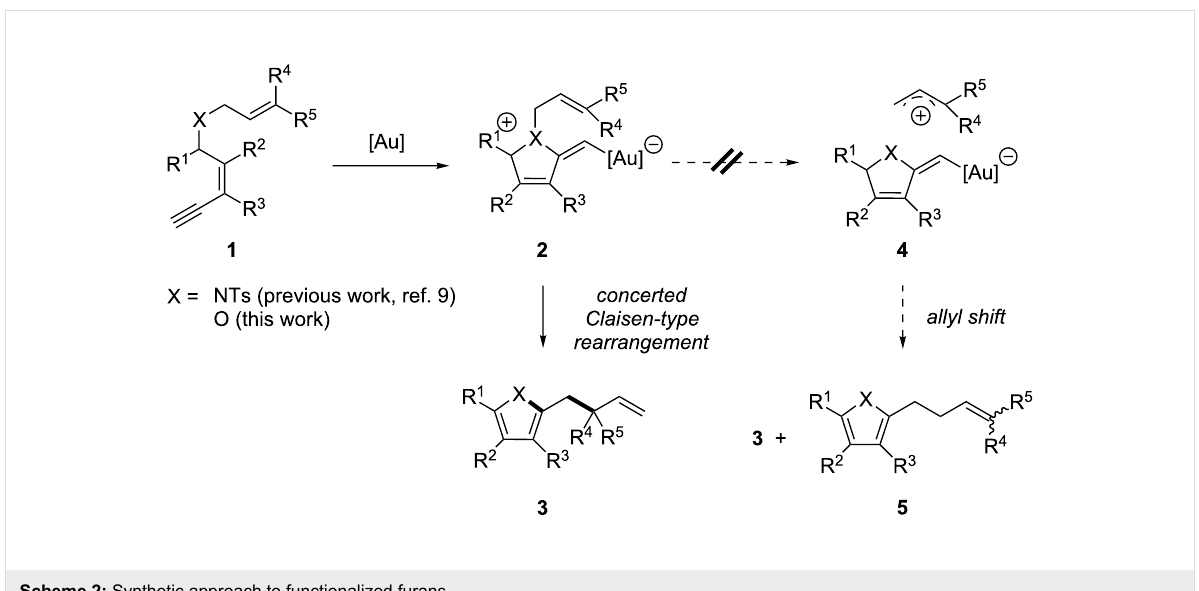
Scheme 2: Synthetic approach to functionalized